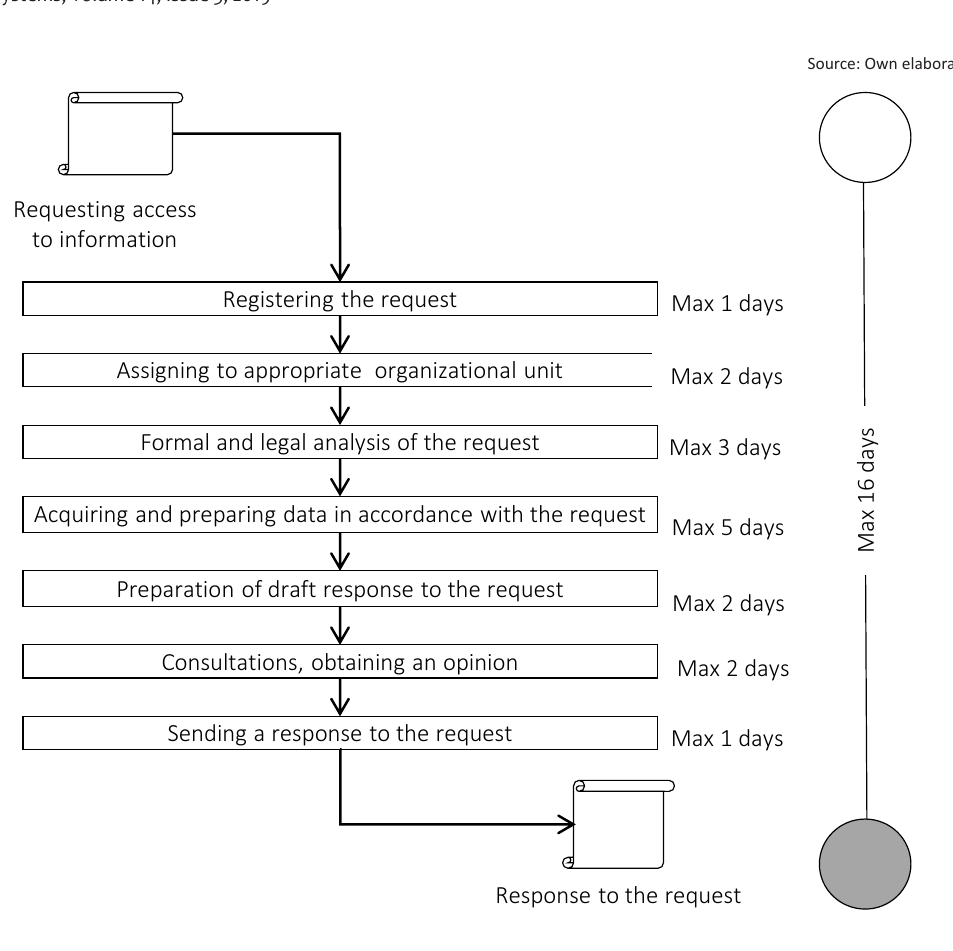
Figure 1. The process of provision of information constituting a bank secret prior to the use of the RPA